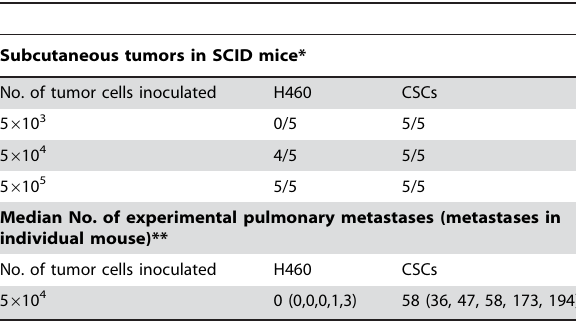
Table 1. Tumorigenic and metastatic properties of H460 cells and lung CSCs.